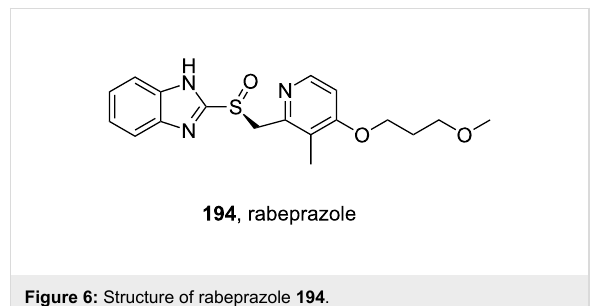
Figure 6: Structure of rabeprazole 194